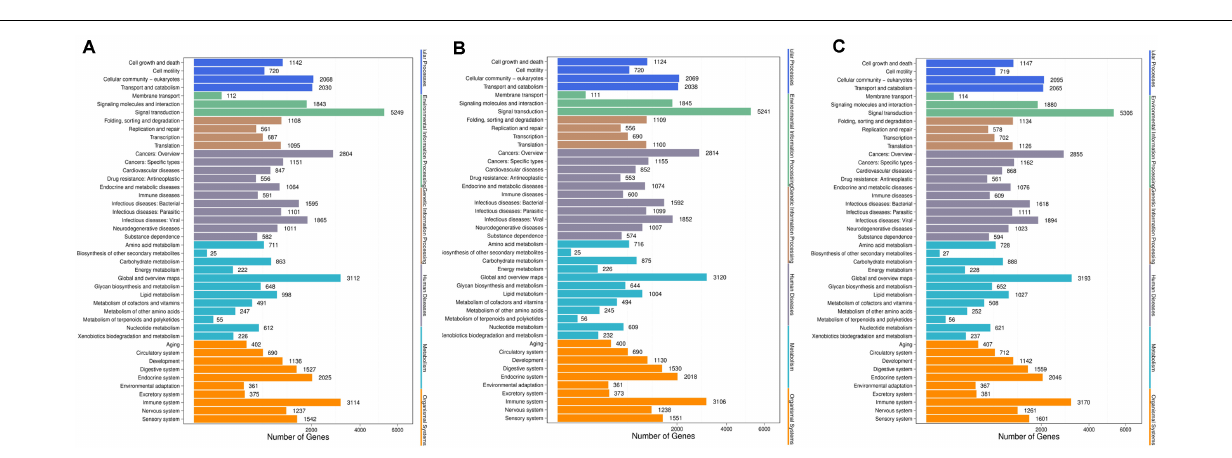
FIGURE 9 | KEGG classification of each pairwise. (A) Comparison between negative control group and positive control group. (B) Comparison between negative control group and P-ONE. (C) Comparison between negative control group and P-TWO. X -axis means number of DEGs. Y -axis represents second KEGG pathway terms. All second pathway terms are grouped in top pathway terms indicated in different